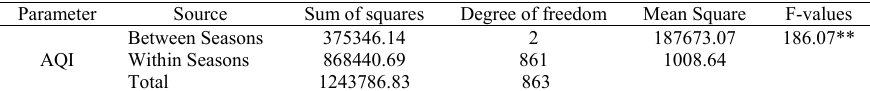
Table 9: One- way ANOVA Test for AQI based on seasons